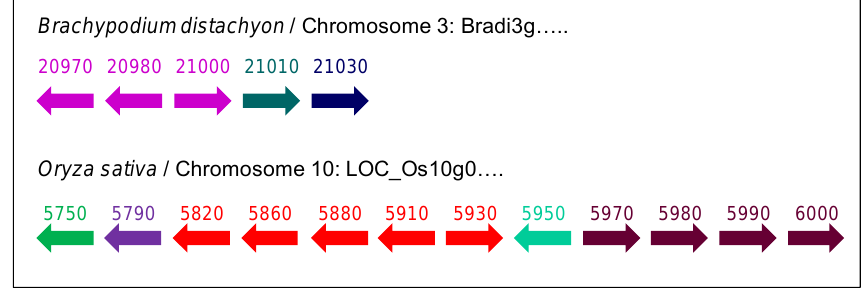
Figure 3. Examples of domain containing-protein (PDP) genes organized in tandem in the B. distachyon and O. sativa genomes. The orientation of the genes is indicated by arrows. The names of the genes are abbreviated, e.g., 20970 stands for Bradi3g20970 , and 5750 for O. sativa LOC_Os10g5750 . Genes sharing more than 85% identity in their PAC domain coding sequences at the amino acid level are represented with arrows of the same color.